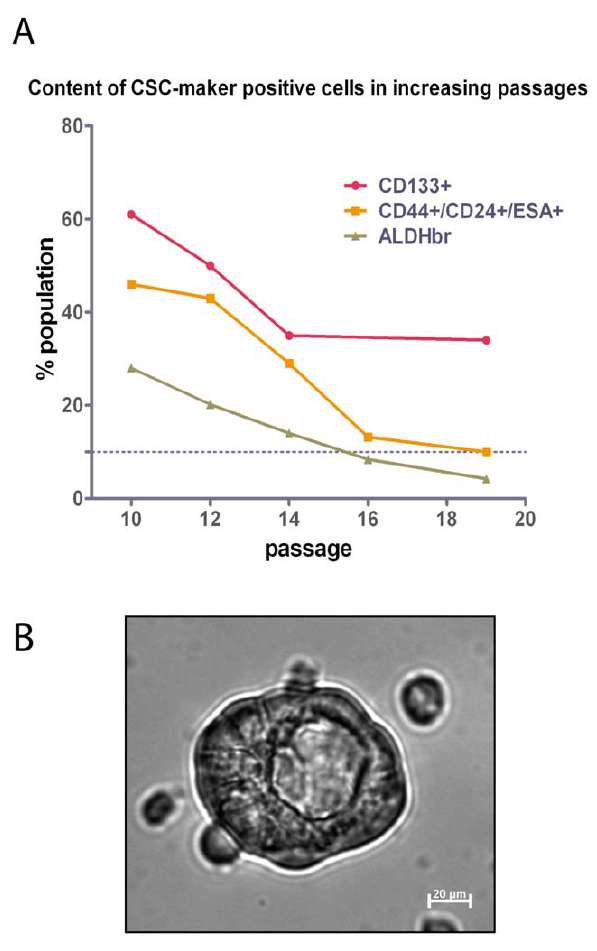
Figure 10. Content of CSC-marker positive cells in increasing passages and a hollow tumoursphere. A. Shown here is the content of cancer stem cell marker positive cells in increasing passages. Three different markers were determined by FACS for each passage: CD133 + , CD44 + /CD24 + /ESA + and ALDH bright (ALDHbr). Each data point represents the percentage of marker positive cells of the total population of JoPaca-1. B. Phase contrast image of a hollow tumour- sphere of JoPaca-1 after cultivation in dedicated medium in a low- attachment culture plate.